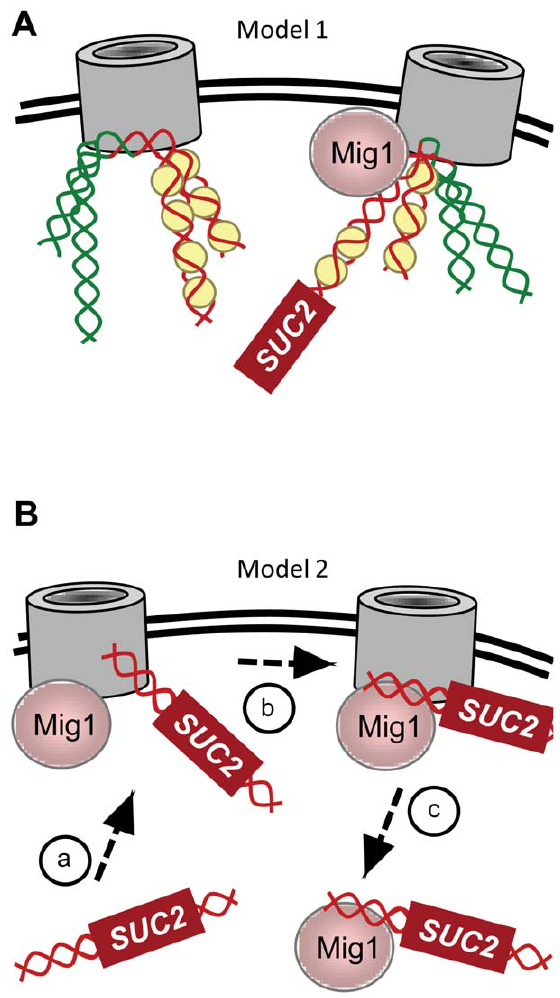
Figure 8. Two models for NPC-dependent Mig1 repression. (A) Model 1, NPCs mark transcriptional boundaries and help regulate nucleosome position. NPCs interact with chromatin, establishing boundaries between active (green) and inactive (red) portions of the genome (represented by four loci on two DNA molecules attached to each nuclear pore). These boundaries provide a register from which the fine-scale positioning of nucleosomes can be established (nuclear pore on the left). By accumulating in the perinuclear subcompartment during growth on glucose, Mig1 can easily find its site immediately after SUC2 has visited the NPC and its promoter nucleosomes have been reset (nuclear pore on the right). In this model, deletion of either NUP120 or NUP133 disrupts nucleosome positioning throughout the genome, so that multiple Mig1 sites are masked and the repressor is blocked from binding DNA (not illustrated). (B) Model 2, NPCs facilitate DNA binding. (a) In the presence of glucose, Mig1 accumulates in the perinuclear subcompartment and SUC2 makes transient contact with NPCs. (b) Increased local concentration of both the promoter and the repressor facilitates Mig1 binding to its consensus site upstream of SUC2 and other target genes. (c) The repressed gene then moves back into the lumen, bound by Mig1. An alternative model not ruled out by the data presented here is that transient contact between Mig1 and the gene at NPCs is sufficient for repression. In this model, deletion of either NUP120 or NUP133 alters NPC structure in such a way that Mig1 can no longer associate, and thus can neither bind to DNA nor repress transcription from the promoters of glucose-repressed target genes. It should be noted that models (A) and (B) are not mutually